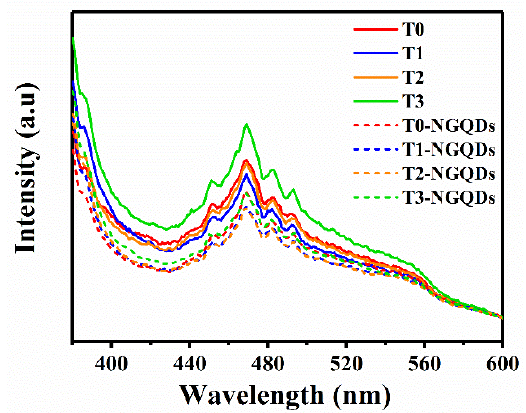
Figure 7. PL spectra of di ff erent TiO 2 samples without and with NGQDs decoration.